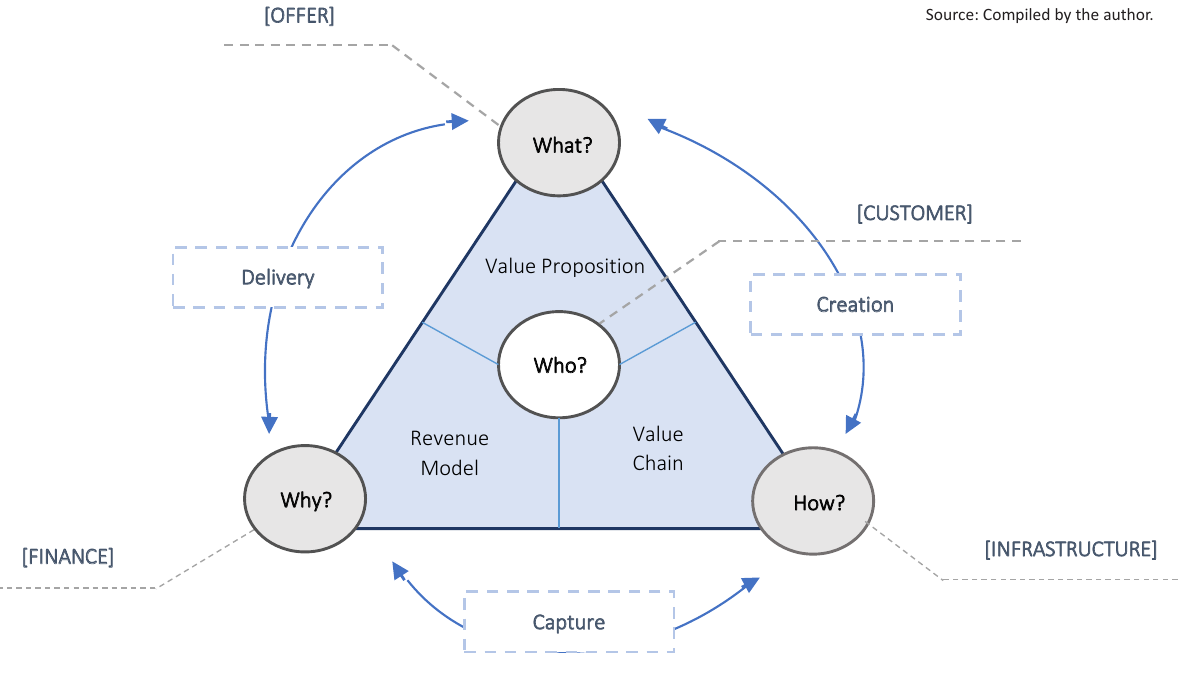
Figure 2. Business model